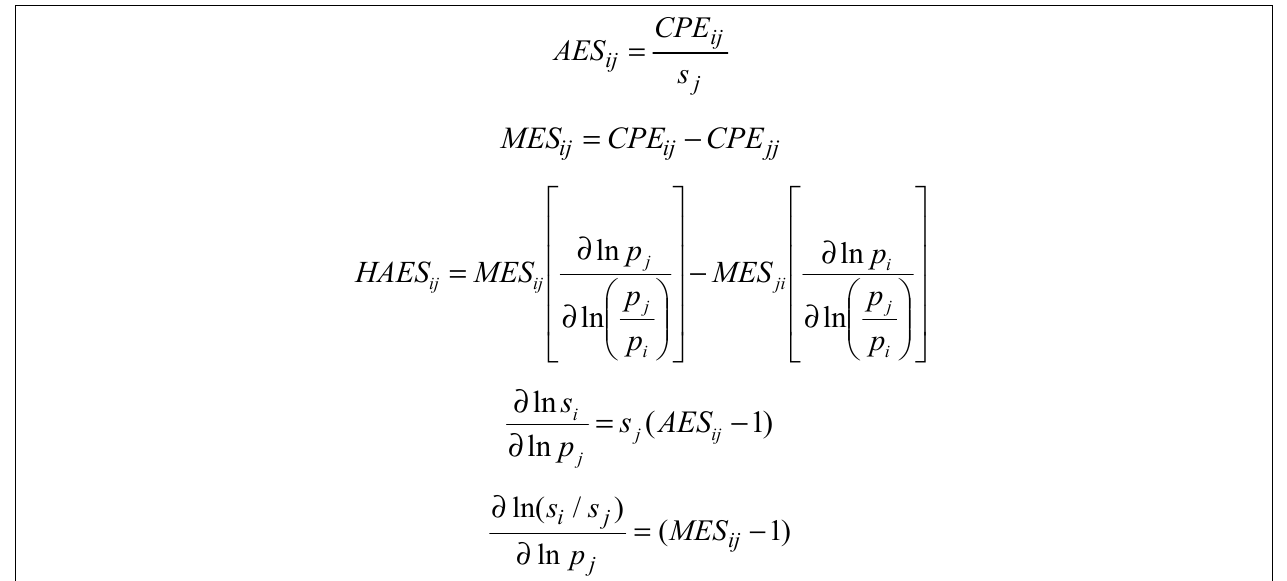
Box 1. Relationships among common substitution